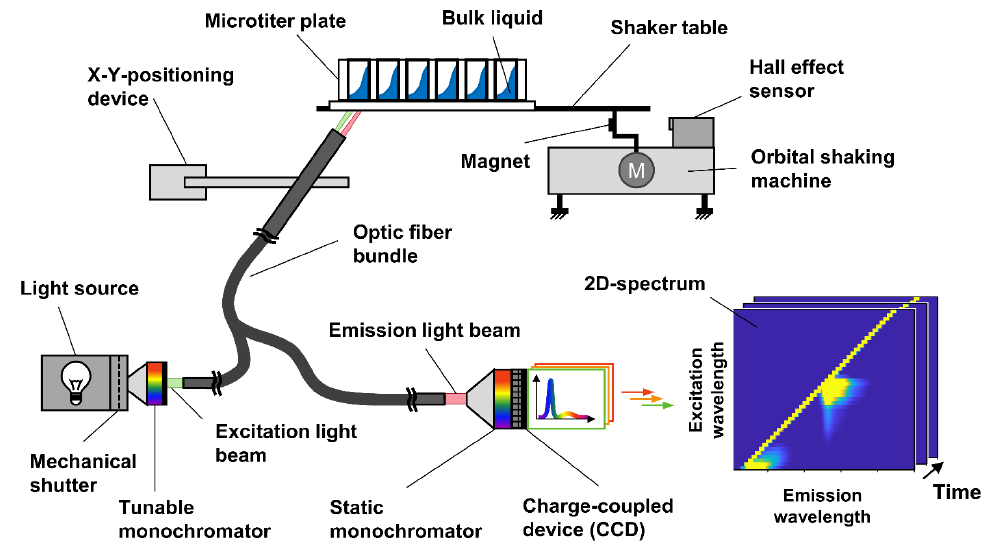
Figure 1. Schematic setup of cultivation system for 2D fluorescence online monitoring in microtiter plates. The shaker table provides continuous shaking of the microtiter plate (MTP). The optical fibre is displaced below each well of the MTP by an X–Y-positioning device. With the tuneable monochromator, the excitation wavelength is selected and sent to the MTP via the optical fibre. The emitted light is collected by the fibre and sent to a second static monochromator. The static monochromator disperses the emitted light into its constituent wavelengths. The resulting emission spectrum is recorded by a charge-coupled device (CCD) camera. To guarantee a reproducible shaker-table position during measurement, the spectral measurement of the CCD camera is triggered by a hall sensor. The emission spectra are assembled into 2D spectra for each excitation wavelength scan of each well over the cultivation time. Modified from [45] and used with permission from publisher.